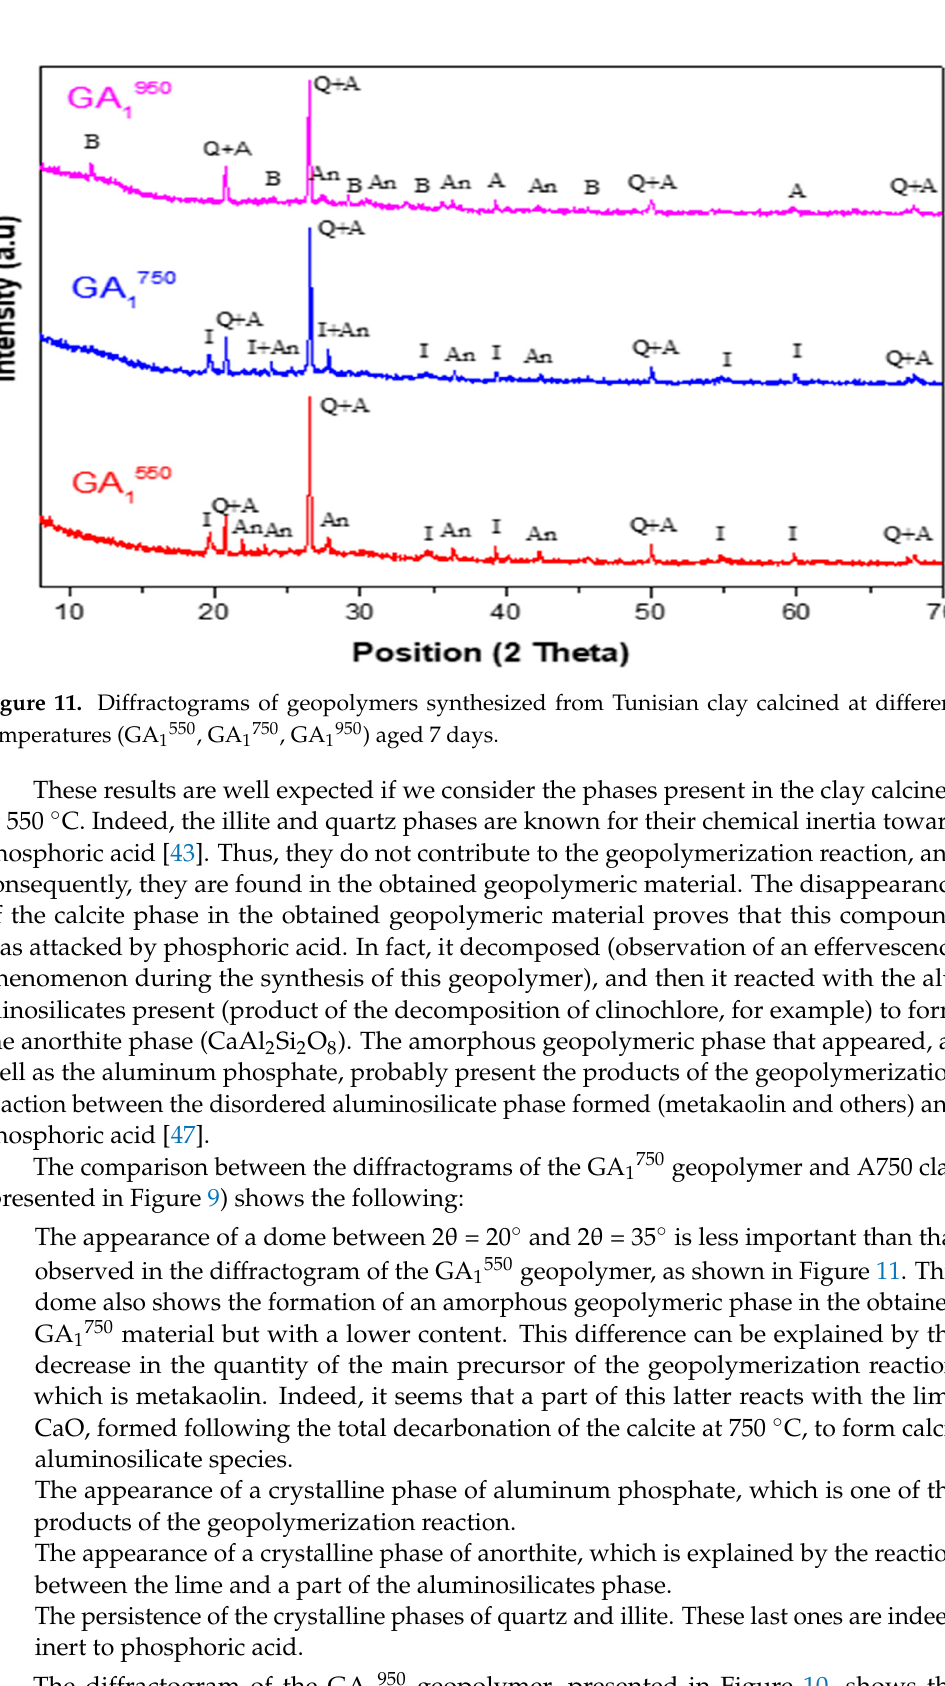
Figure 10. Diffractograms of GA 1950 geopolymer aged 7 days and A950 clay with Q—Quartz (01- 082-0511), I—Illite (00-026-0911), A—Aluminum phosphate (01-084-0853), An—Anorthite (00-012- 0301), B—Brushite (00-011-0293).